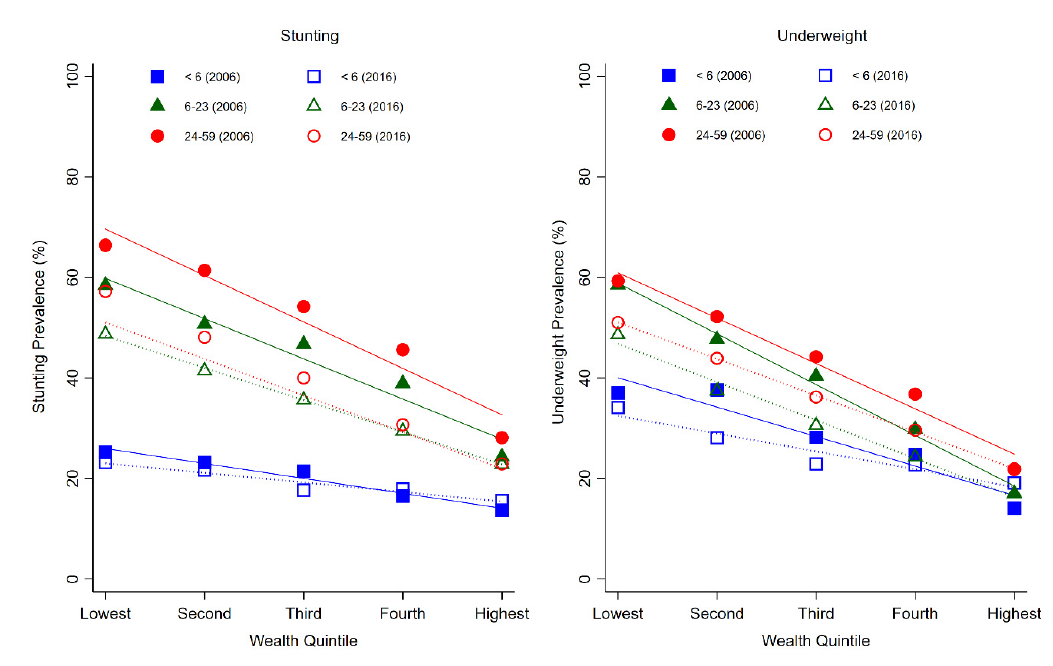
Figure A3. Prevalence of child anthropometric failures across age groups and wealth quintiles, India, NFHS 2006, and 2016.